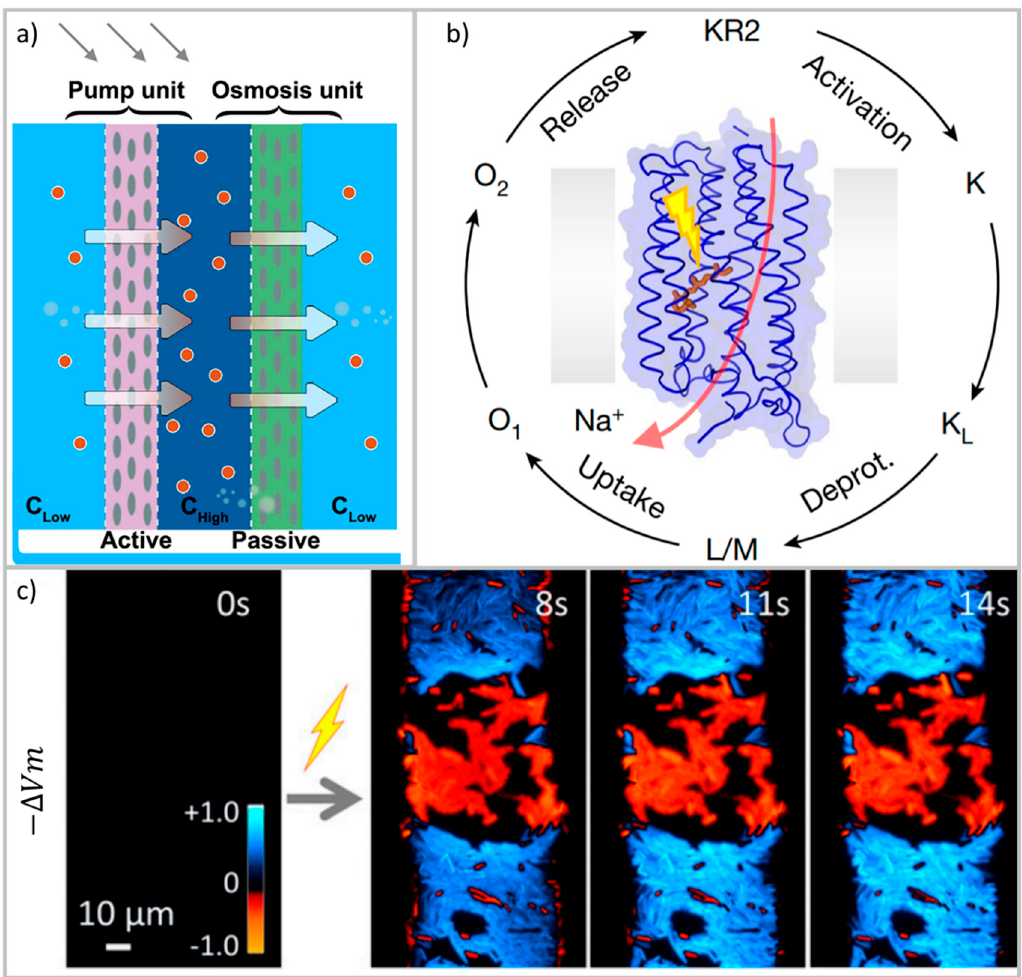
Figure 19. Optically induced membrane potentials causing membrane potential variation. ( a ) ion transport through bacterial membrane using active and passive optical regimes [2]. ( b ) Light driven Na + pump [152]. ( c ) Light induced membrane depolarization (red) due to UV irradiation causing phototoxicity [148]. Reproduced with permission from ( a ) ref. [2] Copyright (2019), Elsevier; ( b ) ref. [152] Copyright (2020), Springer Nature; ( c ) ref. [148] Copyright (2020), National Academy of Science.